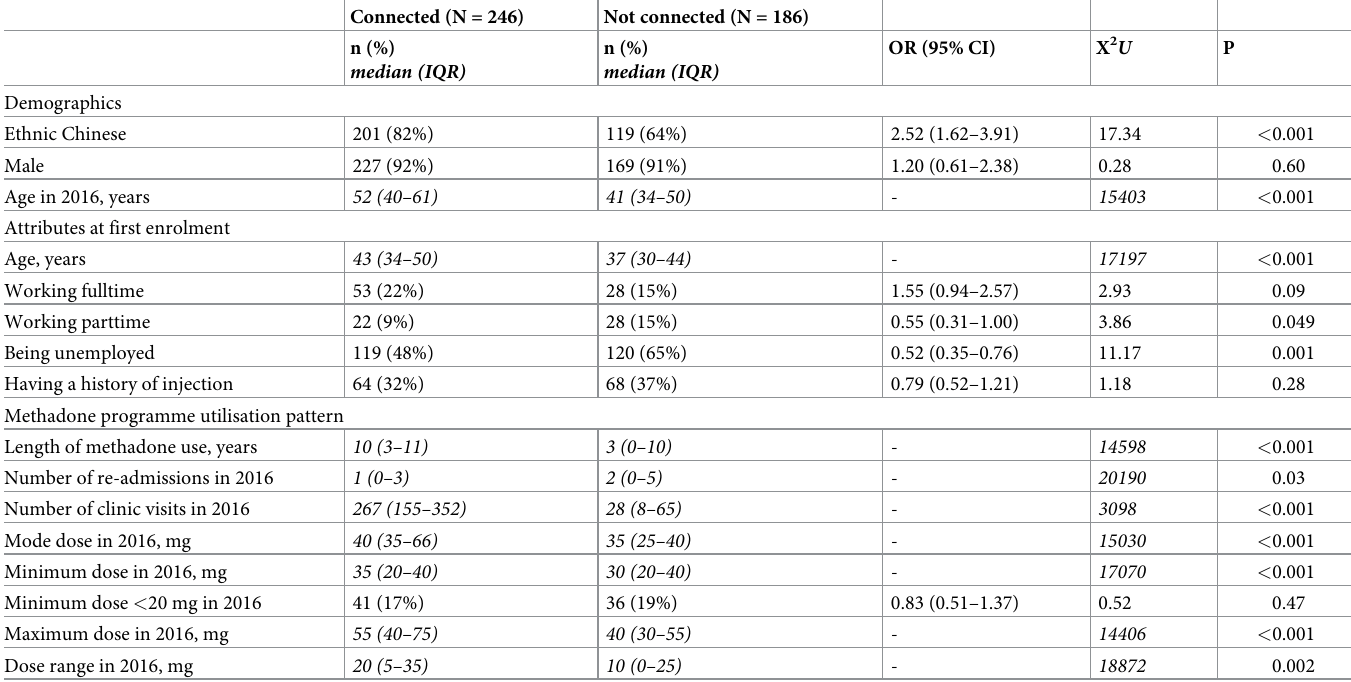
Table 2. Comparison between methadone users active in 2016 with and without social connections with another user (N =